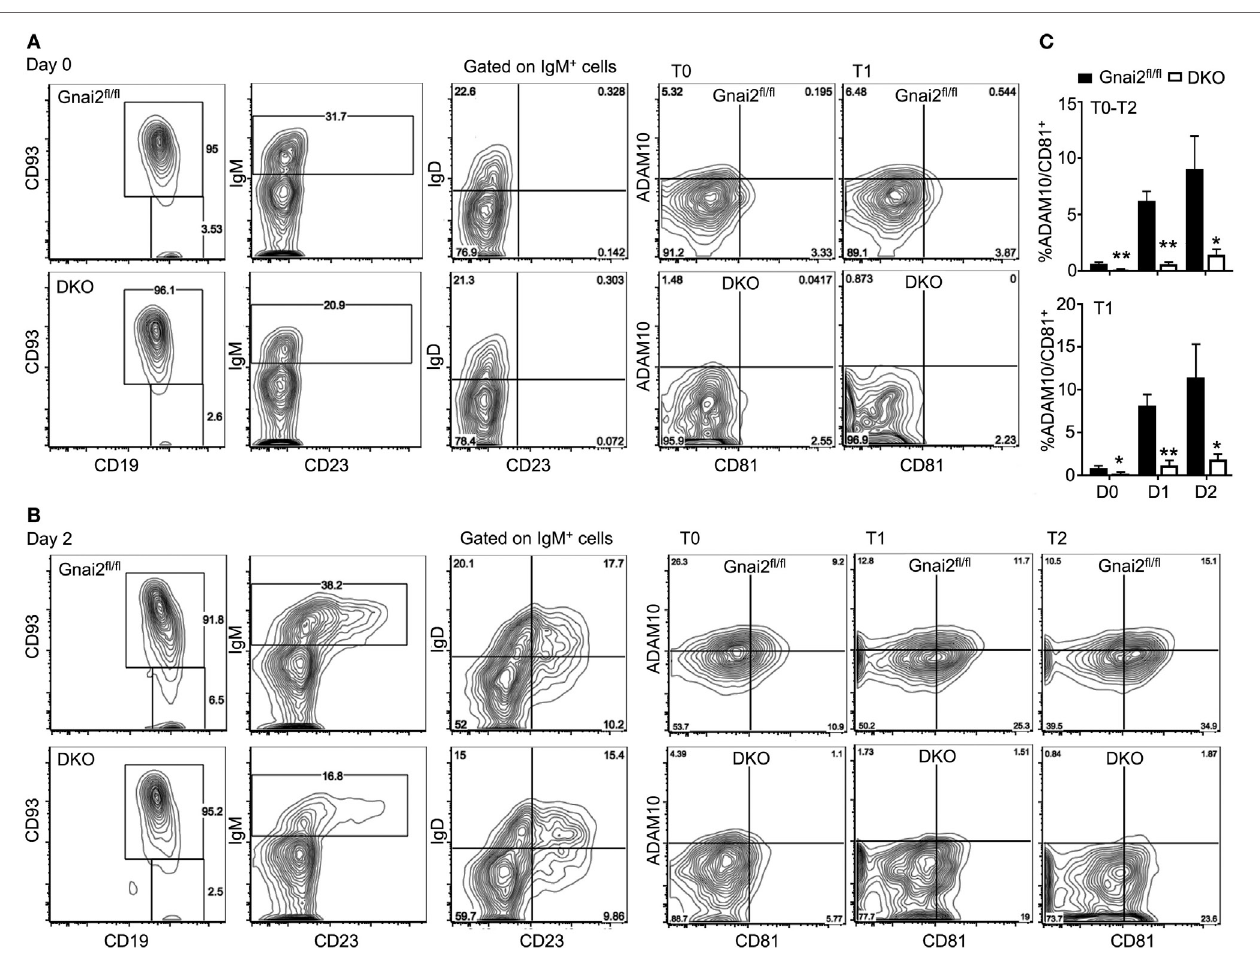
FigUre 8 | Developing G α i -deficient transitional B cells in OP9-Delta-like 1 (DL1) cultures poorly upregulate ADAM10 expression. (a) Representative flow cytometry to analyze IL-7 cultured bone marrow cells. Bone marrow cells from Gnai2 fl/fl or double knockout (DKO) mice cultured with IL-7 for 4 days. Following removal of the non-adherent the cells, the remaining cells were immunostained for CD19, CD93, IgM, IgD, CD23, ADAM10, and CD81. Shown are CD19 versus CD93; IgM versus CD23 gated on CD19 + CD93 + ; IgD versus CD23 gated on CD19 + CD93 + ; CD81 versus ADAM10 gated on CD19 + CD93 + IgM + IgD − [transitional B cell type 0 (T0)]; and CD81 versus ADAM10 gated on CD19 + CD93 + IgM + IgD + CD23 − [transitional B cell type 1 (T1)]. (B) Representative flow cytometry results to analyze B cell development and ADAM10 expression 2 days after plating on OP9-DL1 cells. Bone marrow cells from panel (a) further cultured on OP9-1 cell in the presence of BAFF. The developing B cells from the and DKO mice were characterized by flow cytometry as in panel (a) , but in addition CD81 versus ADAM10 expression is shown on CD19 + CD93 + IgM + IgD + CD23 + [transitional B cell type 2 (T2)] cells. (c) Charts of the % of ADAM10 + CD81 + T0–T2 cells in OP9-DL1 cultures of WT and DKO bone marrow (above) or only the T1 cells (below). Results from the analysis of bone marrow prepared from three WT and four DKO mice. Data are mean ± SEM (* p < 0.05, ** p <